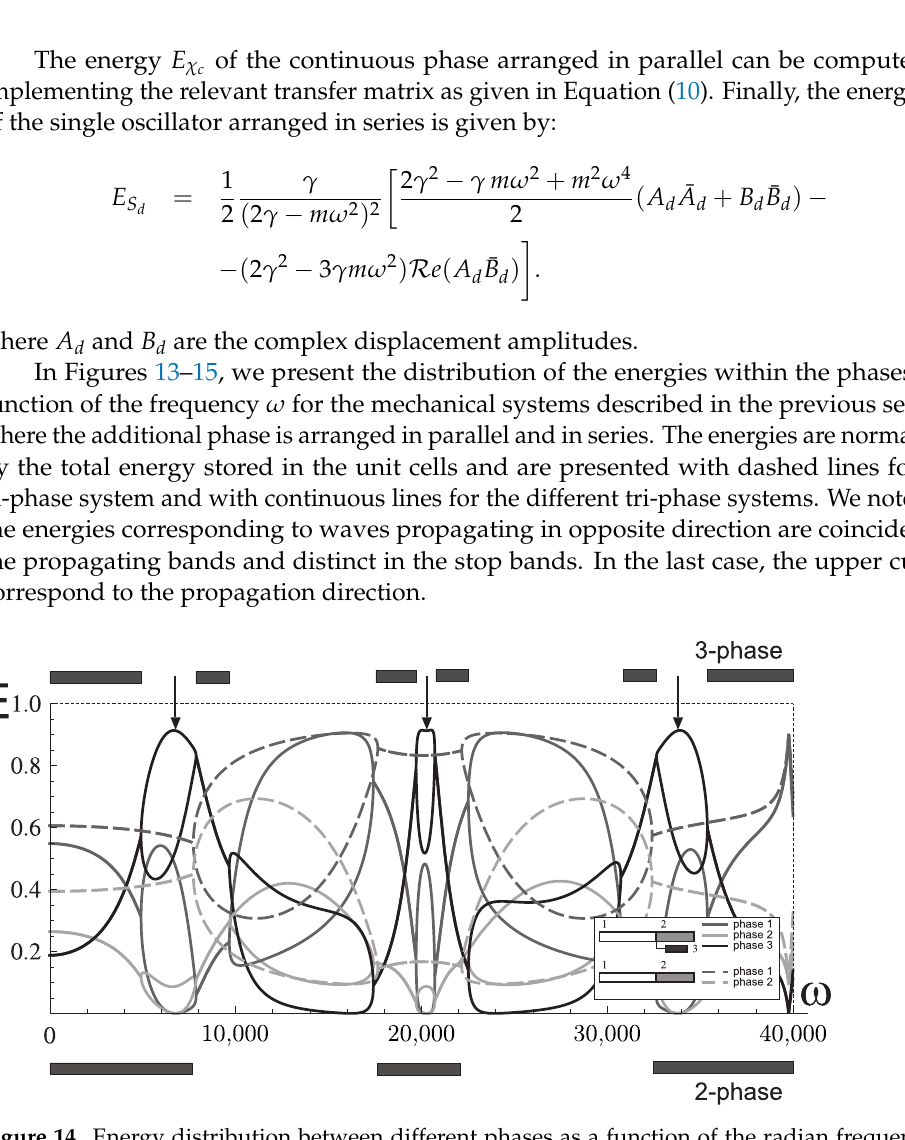
Figure 14. Energy distribution between different phases as a function of the radian frequency ω . Dashed lines correspond to the bi-layered system, while the continuous line corresponds to the bi-layered system with the continuous phase disposed in parallel (indicated in black). Results are given for ξ c = 0.22, η c = 0.5, ξ p = 0.75 and η p = 1.47. Pass band frequency intervals are indicated at the top and at the bottom of the plot. Arrows indicate resonance frequencies of the phase arranged in parallel to the bi-layered